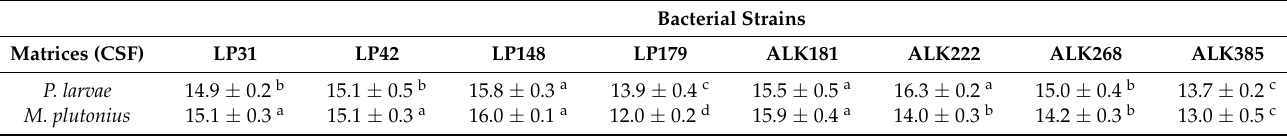
Table 1. Antimicrobial activity by cell-free supernatant (CFS) of the tested Lactiplantibacillus plantarum (LP) and Apilactobacillus kunkeei (ALK) strains against Paenibacillus larvae and Melissococcus plutonius . The data (mean ± SD; n = 3) were expressed as zone of inhibition-ZOI (mm). Different lowercase letters (a–d) in each row indicate significant differences ( p < 0.05).